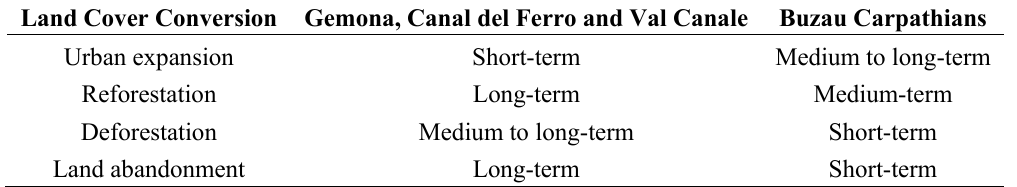
Table 9. Land cover changes as defined as short- or long-term processes. This qualitative evaluation is based on the results of stakeholders’ interviews. Short-term changes were influenced mostly by recent socio-economic changes, whereas long-term ones describe changes specific for the case study for a longer time period than was